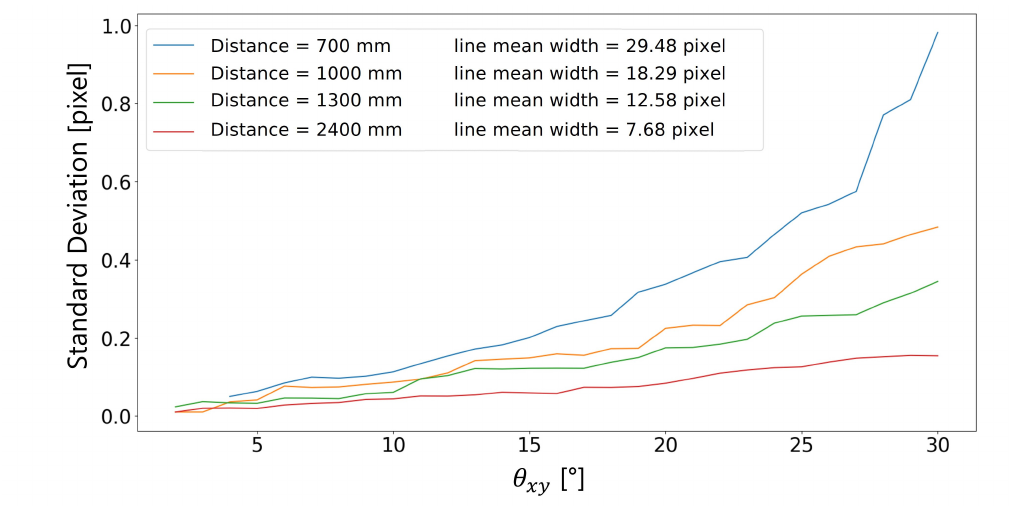
Figure 22. Standard deviation in pixels vs. absolute